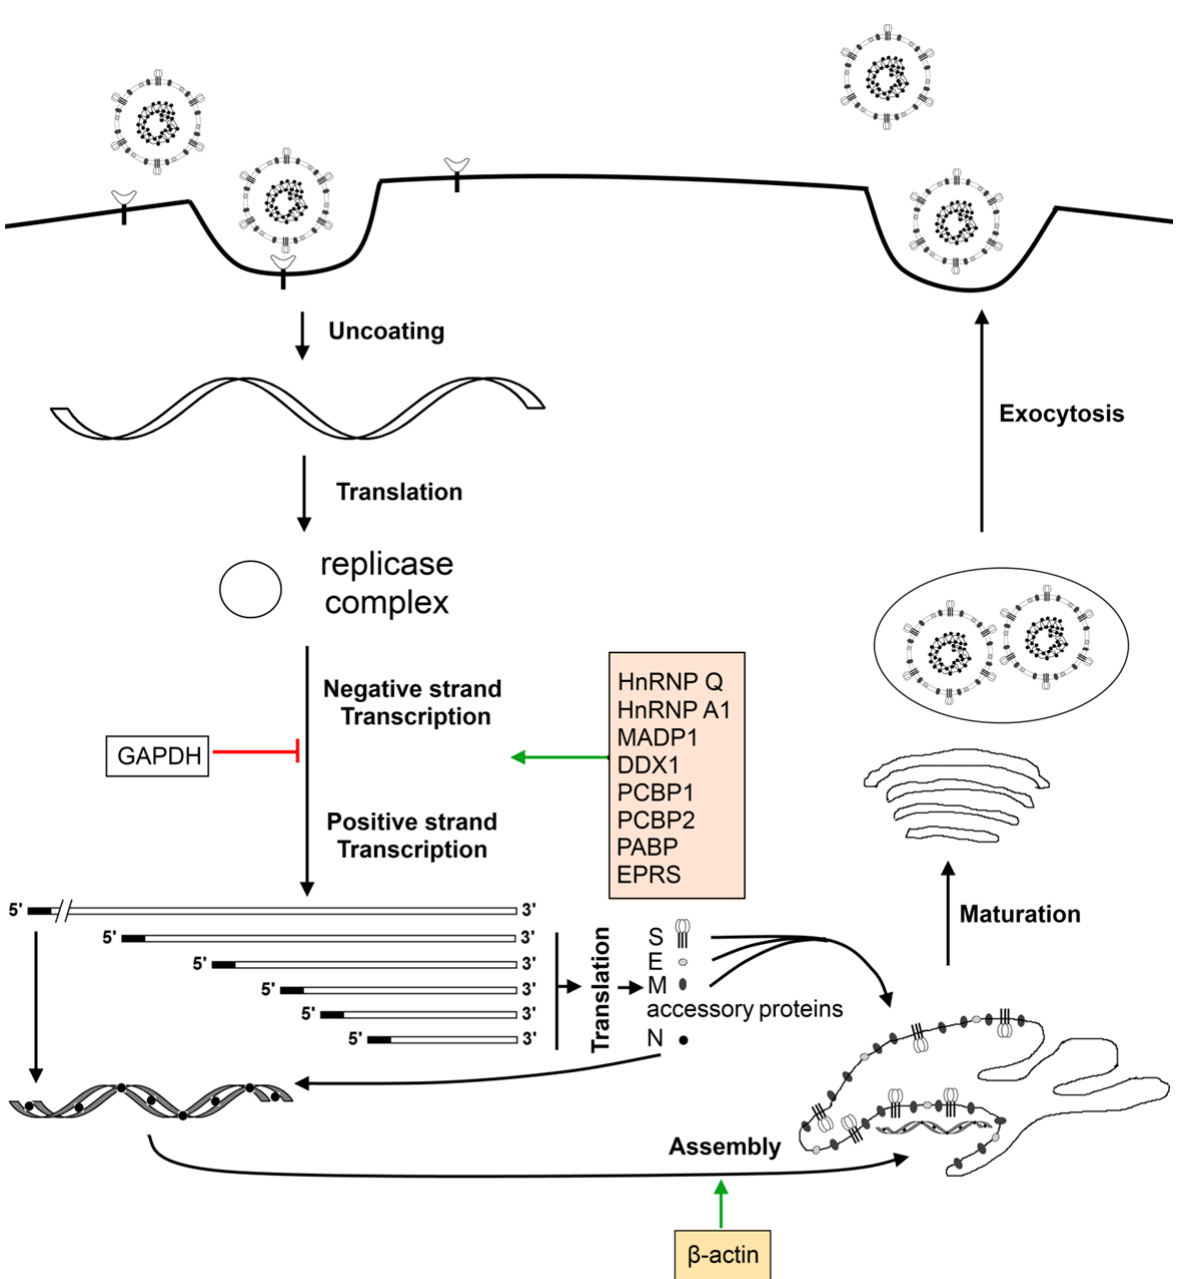
Figure 4. Host proteins and the coronavirus life cycle. Virus particle attaches onto the host cell via cellular receptors on the surface and enters. Entry is followed by the uncoating of the ribonucleocapsid to expose the positive-sense genomic RNA which is translated by the host ribosomes to yield the viral replication complex. The viral replication complex continues with viral transcription and genome replication and, with the aid of host proteins such as hnRNPA1, yields a nested set of positive-sense sub-genomic sized mRNAs as well as the full-length virus genome. Sub-genomic sized mRNAs are translated by host ribosomes into viral structural (S, E, M, N) and accessory proteins. The N protein packages the positive-sense genomic RNA into a ribonucleocapsid and is assembled into the virus particles with the help of  -actin. The newly formed virus particles undergo maturation when passing through the Golgi and exit the host cell via